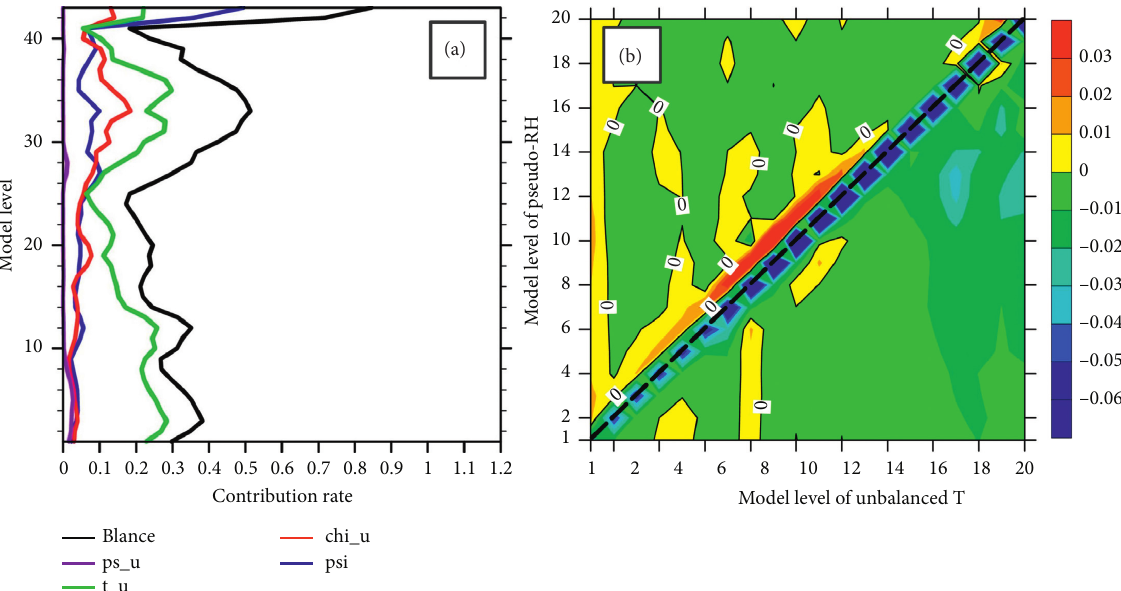
Figure 5: Contribution rates of individual terms to RH level (horizontal axis) for RH s calculation (vertical axis). Thick-dashed line in (b) indicates the regression coefficients at the same